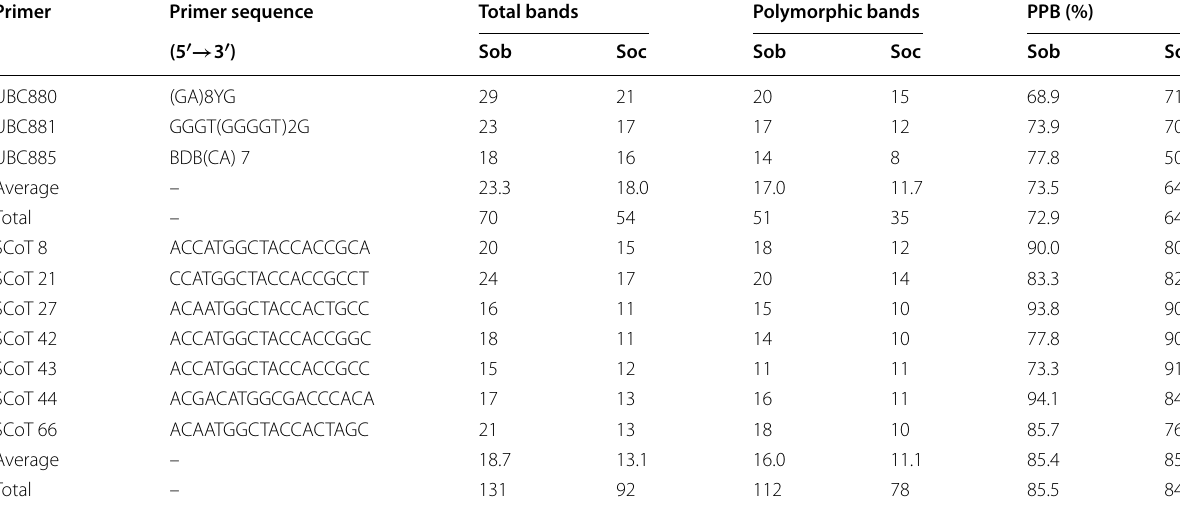
Table 2 Genetic polymorphism parameters of 36 samples generated by 3 ISSR and 7 SCoT primers